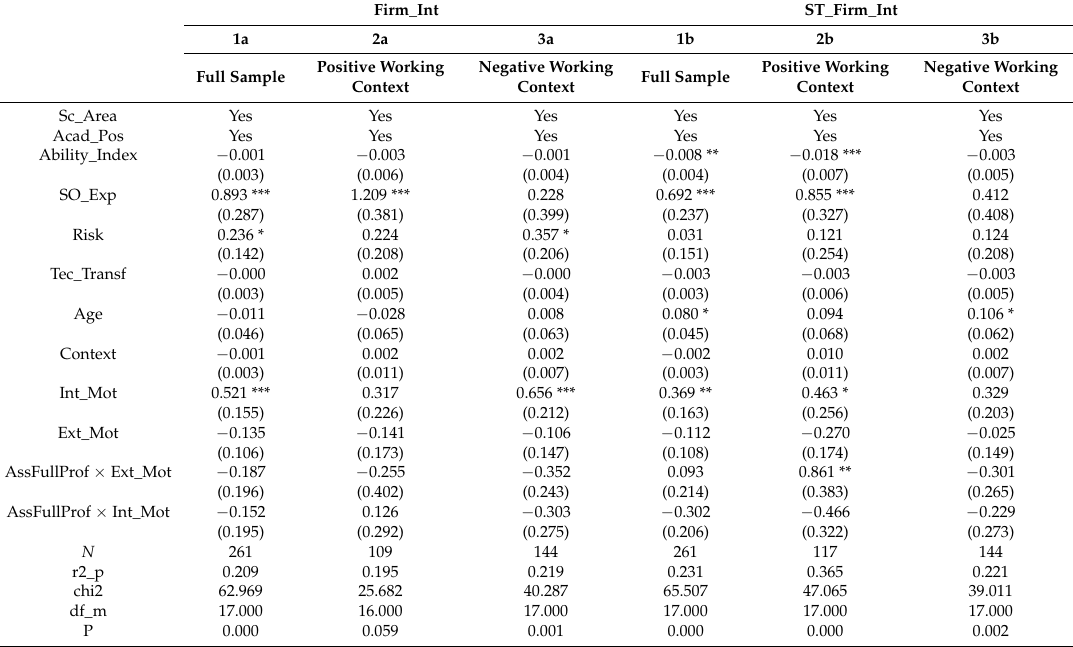
Table 10. Probit results (Marginal effects reported): Motivations interacted with AssFullProf